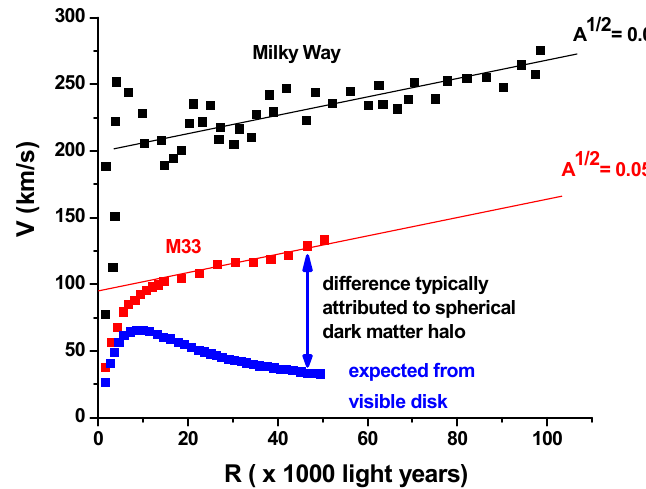
Figure 1. Comparison of the observed rotation curve (red) with the computed rotation curve (blue) obtained based on the unmodified Newtonian dynamics and the visible mass distribution for the typical spiral galaxy M33 [2]. Note that at large distances from the galactic center the observed rotation curve exhibits a slow linear dependence on the radial distance, which is consistent with the expectations based on Equations (22) and (23) for A 1 / 2 ~0.05. The observed rotation curve of the Milky Way (black) [20] exhibits a similar linear dependence of the rotation speed at large distances from the center.